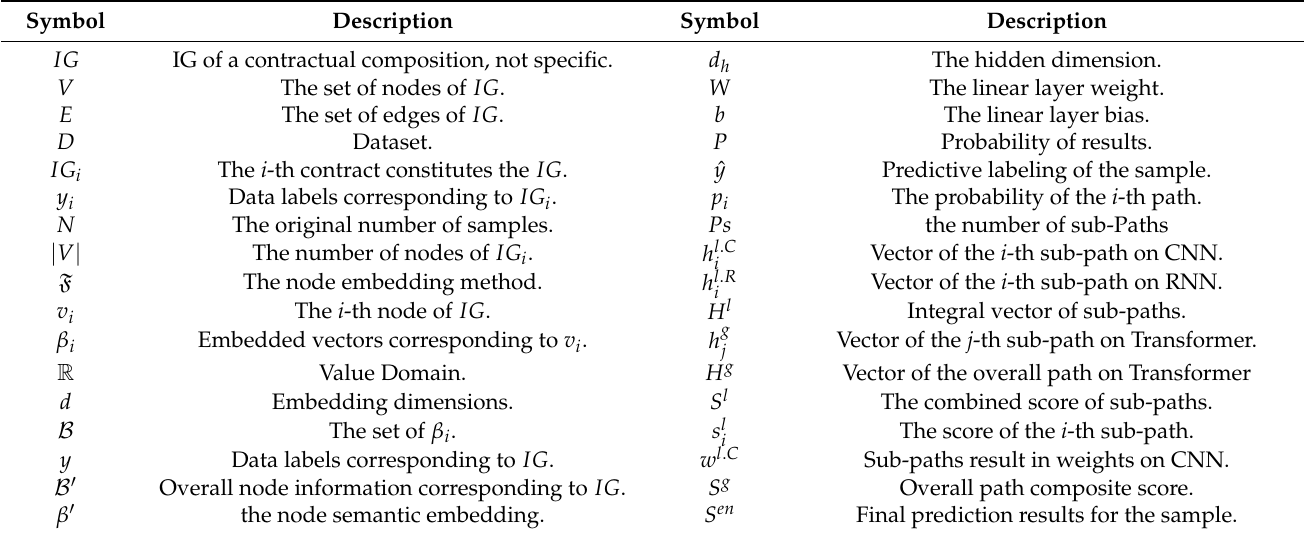
Table 1. Symbols and corresponding descriptions.